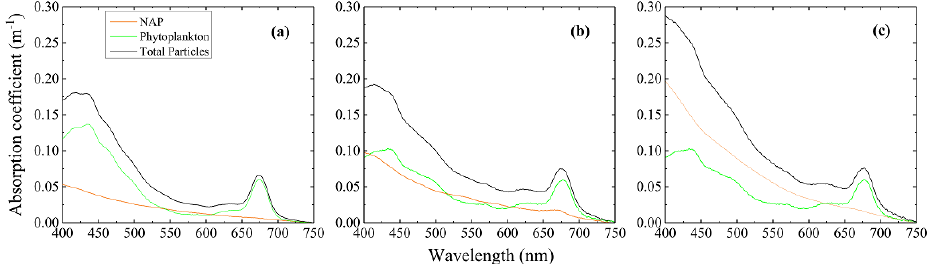
Figure 3. Three typical total particle absorption spectra in Lake Qiandaohu, demonstrating corresponding absorption characteristics for NAP and phytoplankton. ( a ) Phytoplankton are the dominant; ( b ) Neither phytoplankton nor NAP are the dominant ( c ) NAP are the dominant.